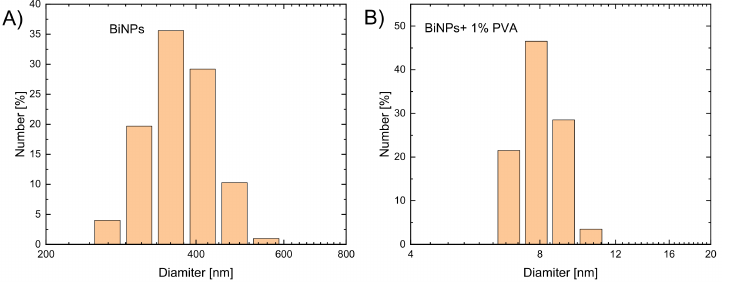
Figure 2. DLS analysis results in the form of particle size histograms according to distribution for ( A ) a solution of bismuth nanoparticles synthesized without a stabilizer (PVA) and ( B ) a solution of bismuth nanoparticles synthesized in the presence of a stabilizer. The bismuth concentration in both cases was 1 × 10 − 4 M.